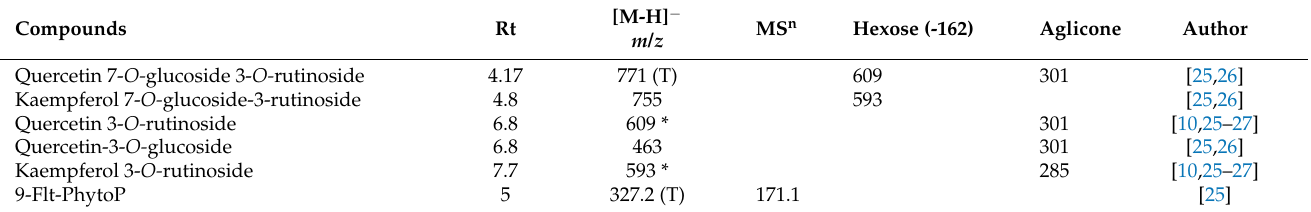
Table 2. Additional flavonoids and phytoprostanes present in BFPP detected by LC-MS analysis in negative mode, and corroborated by previous reports in the